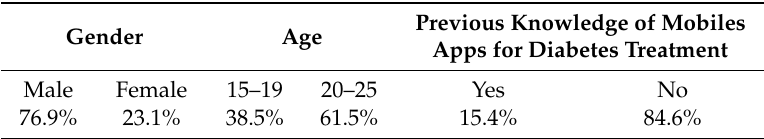
Table 4. Relevant data of testing subjects.